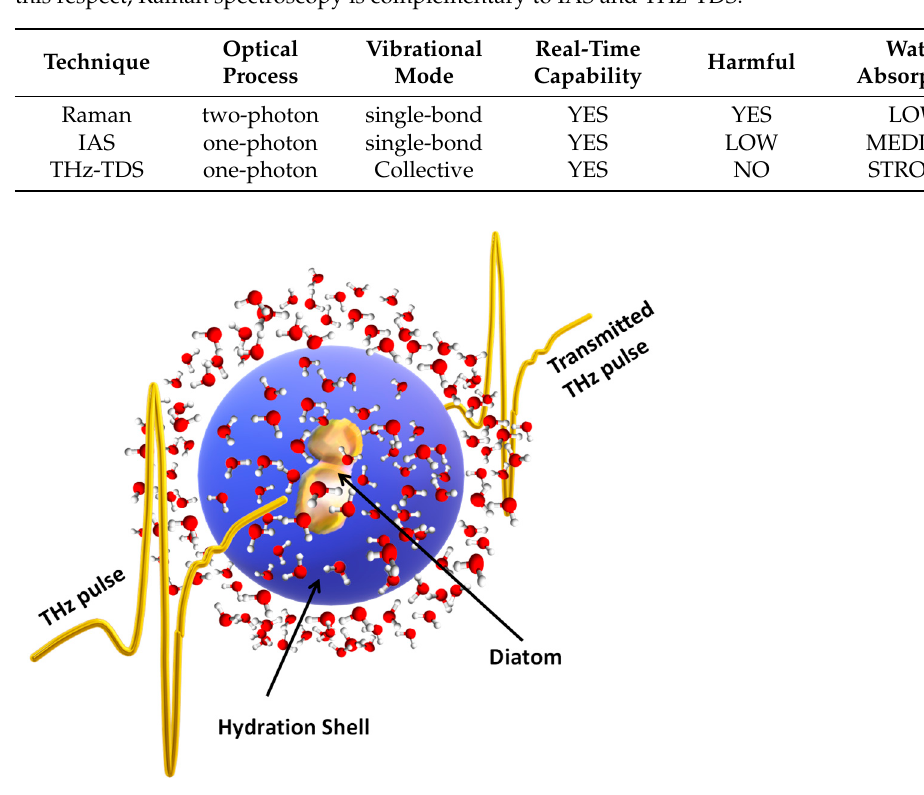
Table 1. Comparison of the main characteristics, strengths, and drawbacks of the different techniques. Note that one- or two-photon processes probe vibrational excitations with different symmetries. In this respect, Raman spectroscopy is complementary to IAS and THz-TDS.